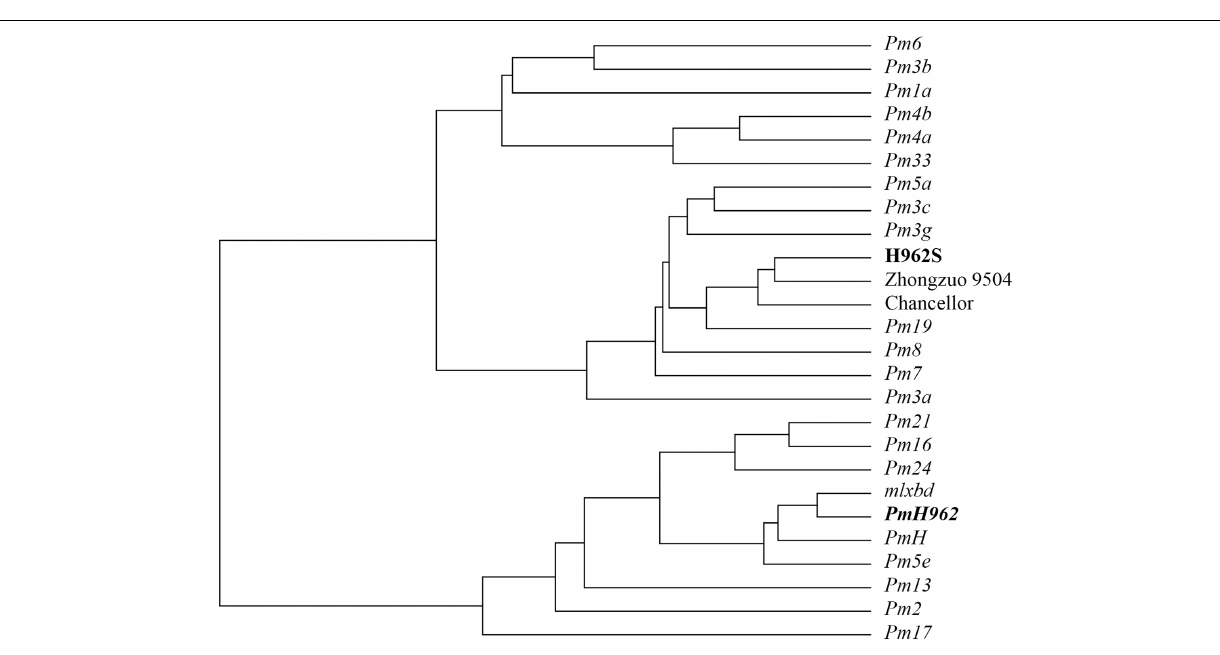
FIGURE 2 | A dendrogram based on reactions of PmH962 and differential wheat cultivars/lines possessing known powdery mildew resistance genes against 103 Blumeria graminis f. sp. tritici